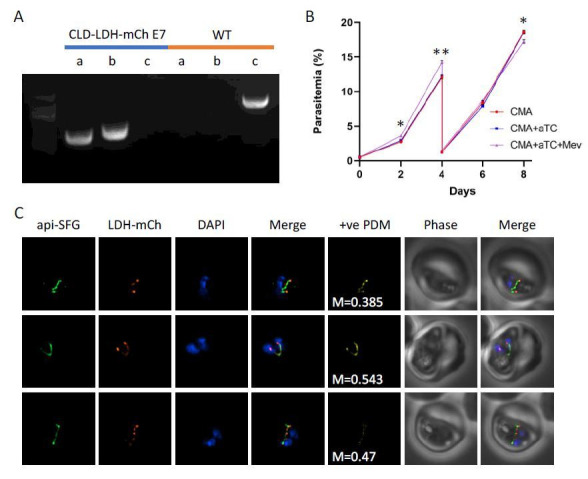
Expression and localization of lactate dehydrogenase (LDH) in the apicoplast.A) Genotyping PCR confirming insertion of CLD-LDH-mCherry (clone E7), with amplification demonstrating plasmid integration at the 5’ and 3’ loci of the P230p locus (lanes a, b), and lack of wild-type parasites due to failure to amplify at the wild type locus (lane c), as compared to the parental control (WT). B) Growth curve of the CLD-LDH-mCh parasite line cultured with 500nM aTC (aTC), aTC and 50μM mevalonate (Mev), or without supplements (CMA). C) Live epifluorescence microscopy of the CLD-LDH-mCherry parasite line. This line expresses api-SFG (green) and CLD-LDH-mCherry (red), while DAPI (blue) marks the nucleus. Microscopy images represent fields that are 10μM long by 10μM wide and include Mander’s values and positive product of the differences from the mean (+vePDM) panels.